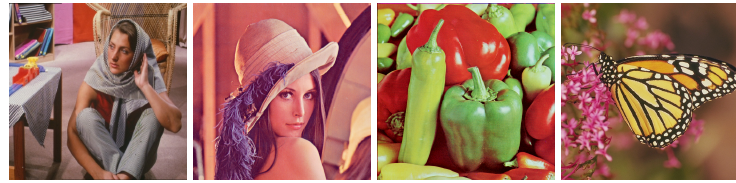
Figure 1. Original images: Barbara, Lena, Peppers, and Monarch (from left to